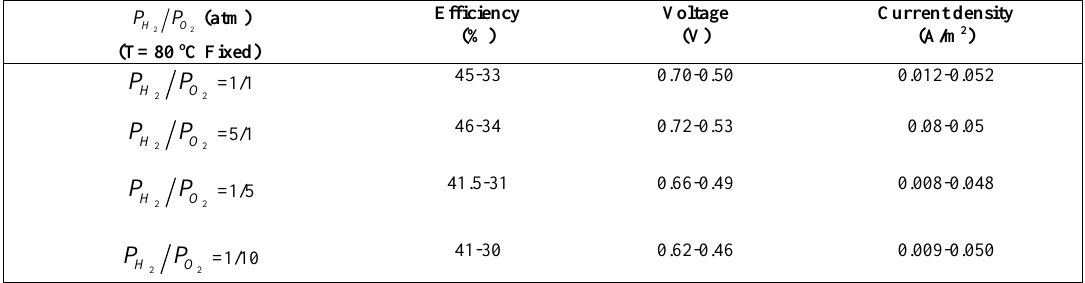
Table 5. PEMFC performance at constant reactants flow pressure and temperature variation